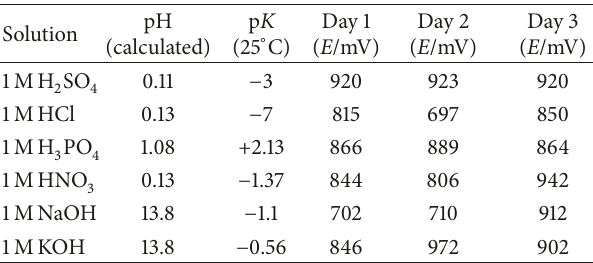
Table 1: Drift of the OCP ( E versus RHE) of a RuO 2 electrode in various acids and bases at 25 ∘ C in the course of several days. For comparison: negative decadic logarithm of the dissociation constants of acids (p 𝐾 a ) and bases (p 𝐾 b ) from [12]. Theoretical potential of the reversible hydrogen electrode: V RHE = 0.059 pH